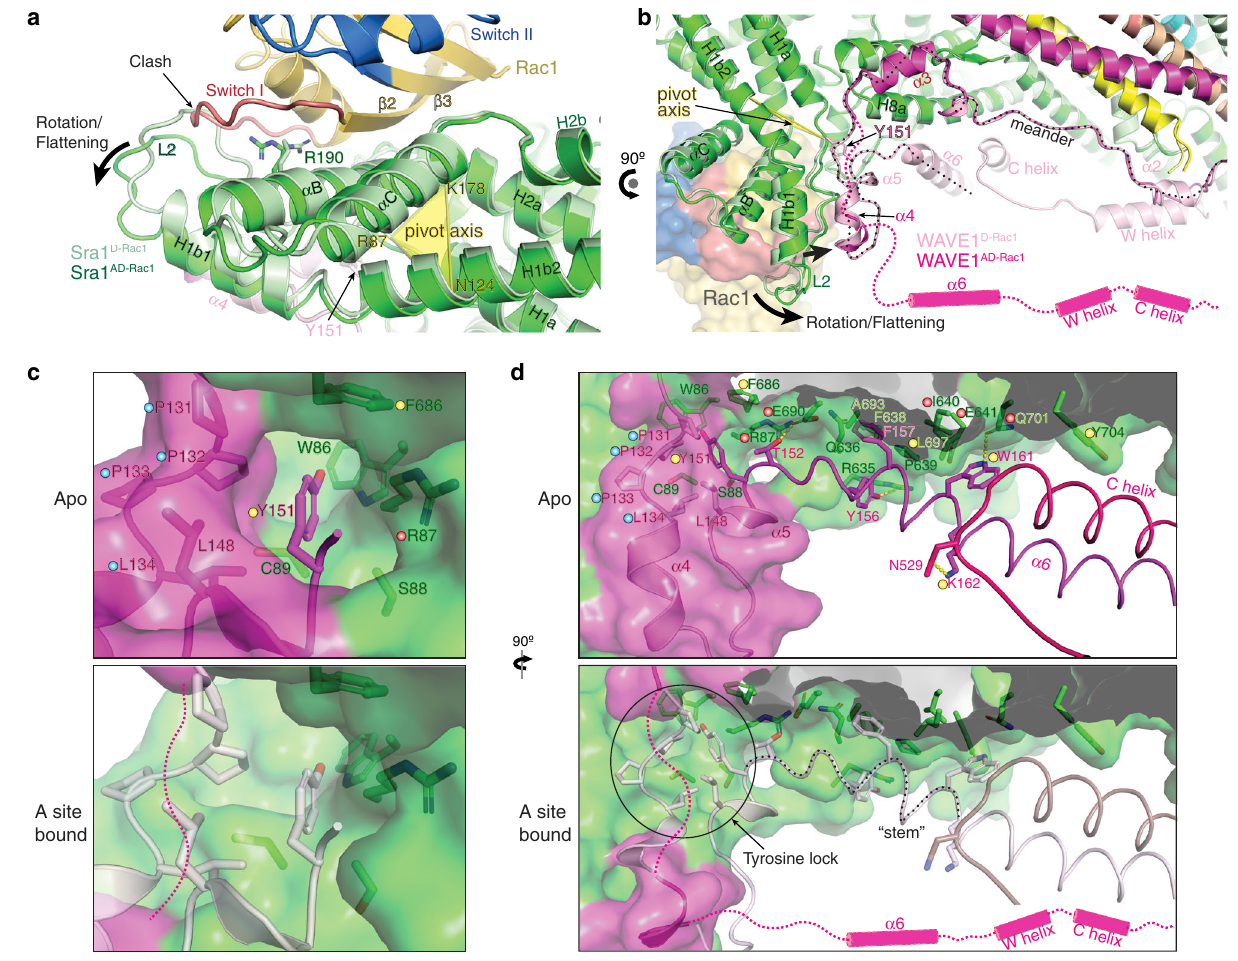
Fig. 4 | Rac1 binding to the A site drives a conformational change to release WCA.a , b OverlayofWRC AD-Rac1 (darkcolors)andWRC D-Rac1 (lightcolors)structures showing conformational changes of the A site upon Rac1 binding. Sequences of which the densities are not observed in WRC AD-Rac1 structure, but are present